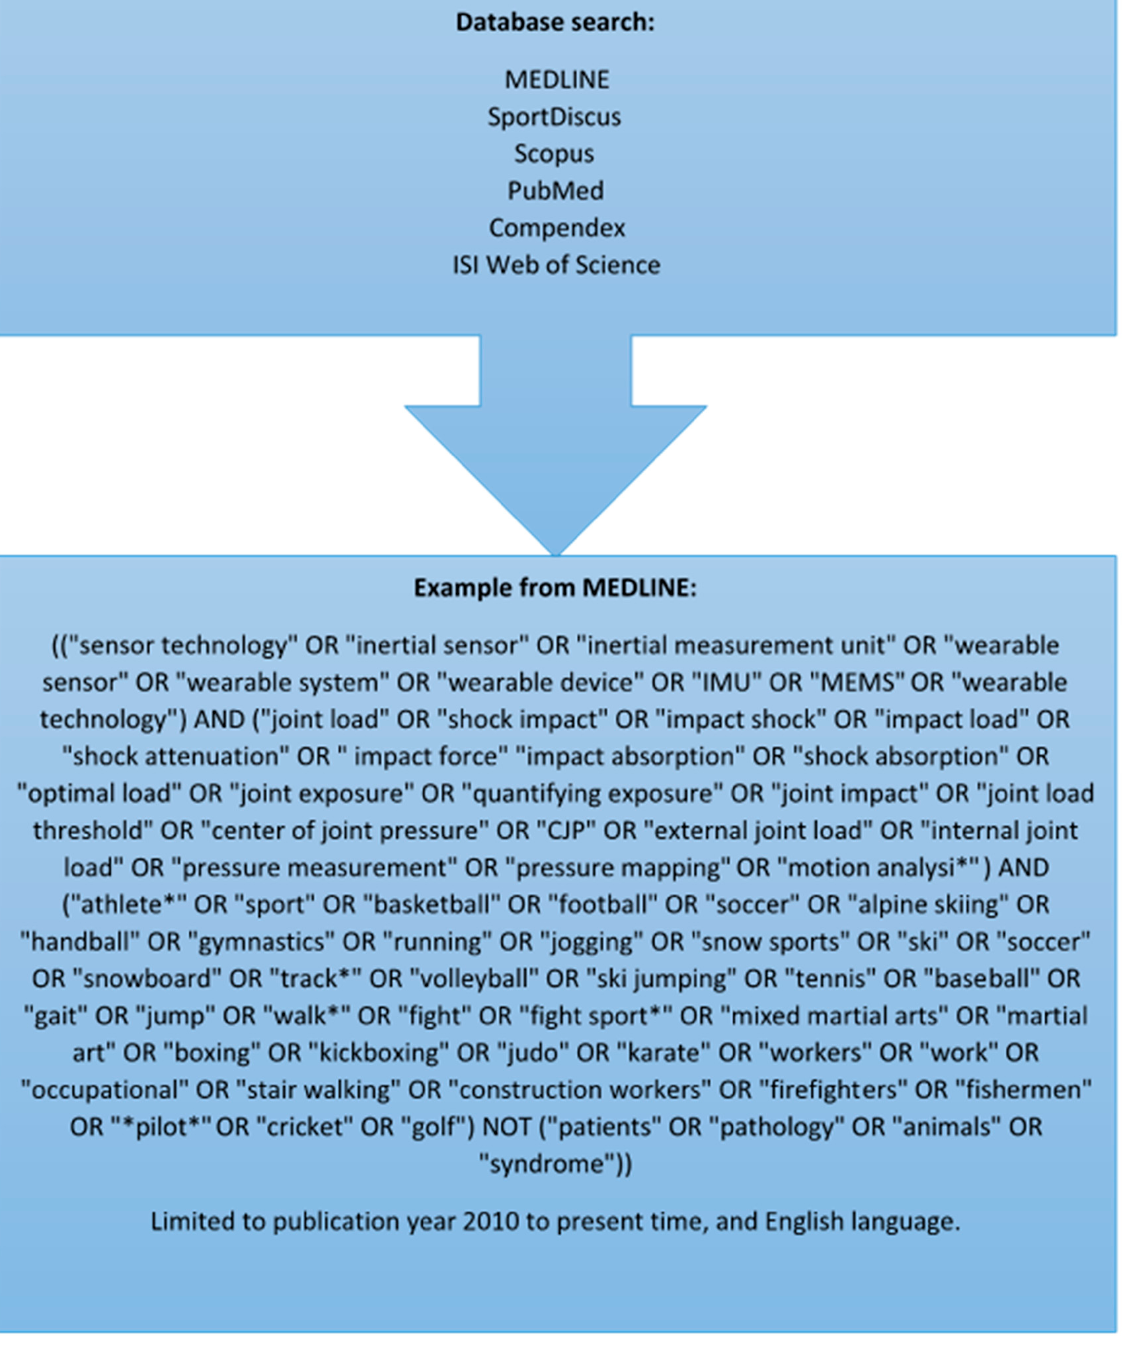
Figure A1. Search strategy.